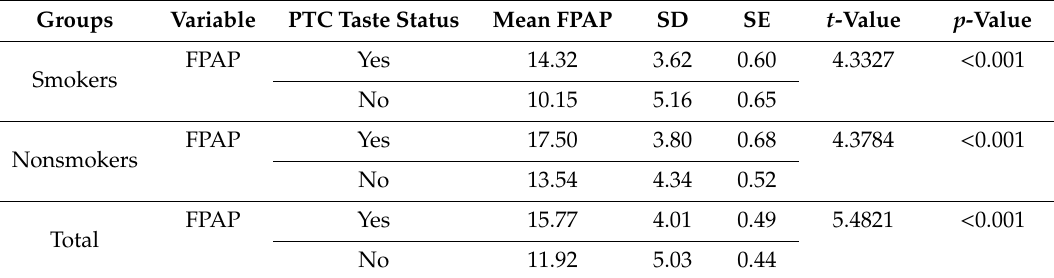
Table 3. Comparison of PTC tasting status with FPAP scores in smokers, nonsmokers, and all subjects by the independent t-test.